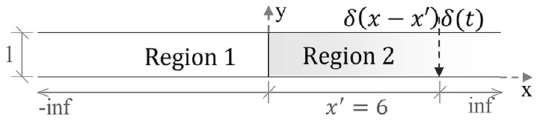
Figure 7. The problem solved in example 2.